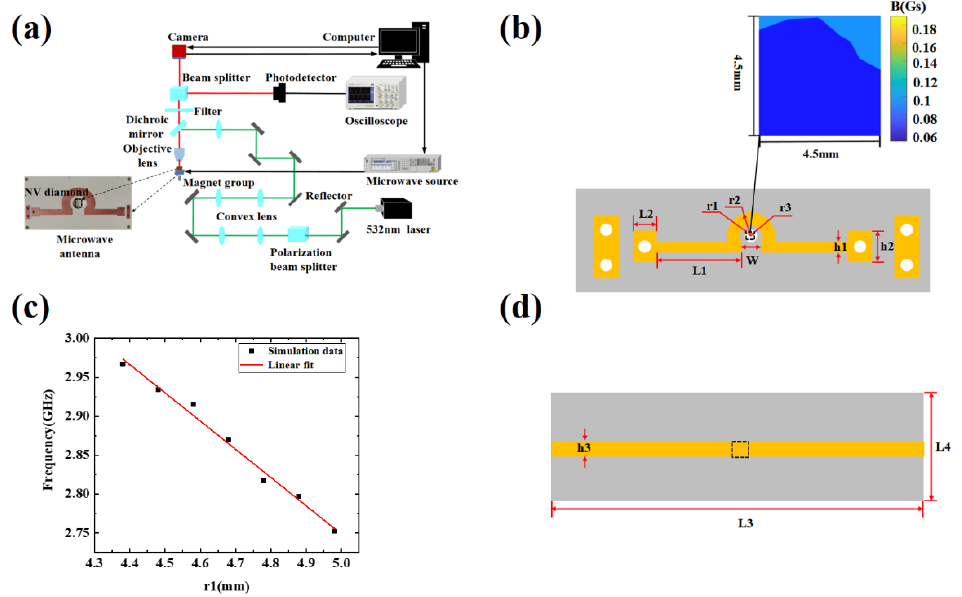
Figure 1. ( a ) Experimental system; ( b ) Schematic diagram of antenna model; ( c ) Relationship be- tween r1 and simulated resonant frequency; ( d ) Straight copper antenna schematic diagram and measurement position (L3 = 59 mm, L4 = 44 mm, h3 = 2 mm, the thickness is 1.524 mm).